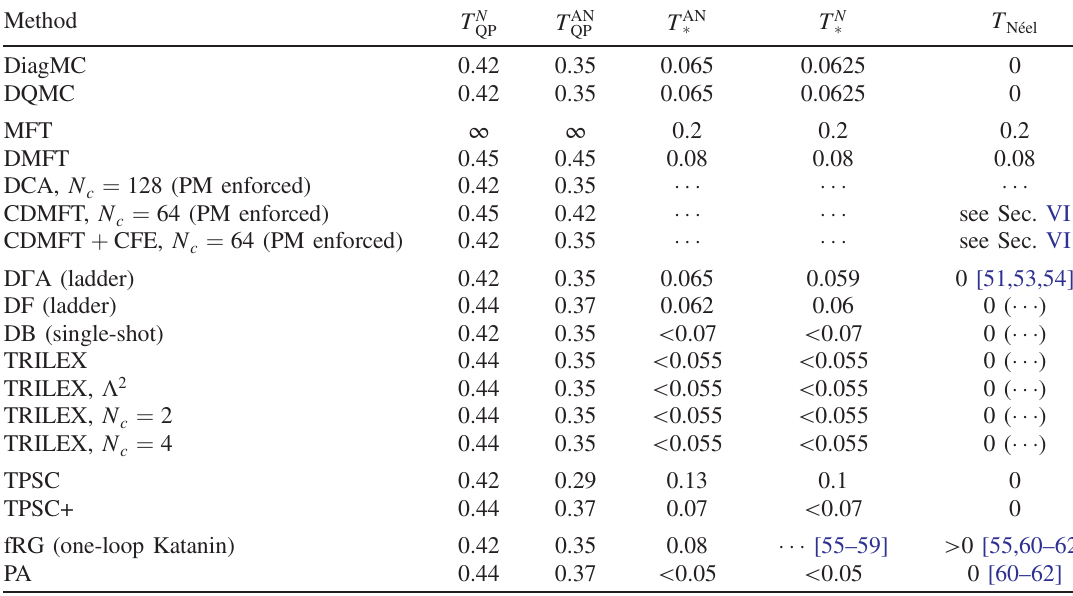
TABLE I. Temperature scales discriminating the regions ① – ⑤ of Fig. 2 calculated using various many-body techniques.